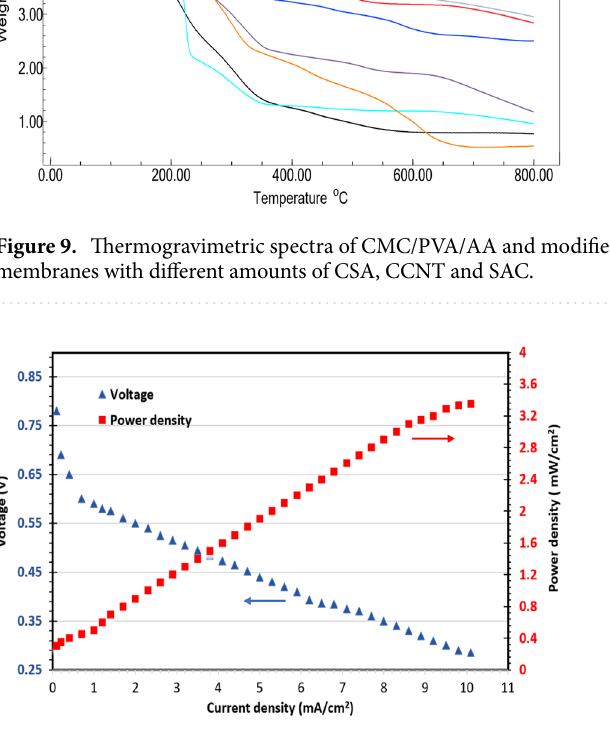
Figure 10. Polarization curves and power density of DMFC with CMC/PVA/AA-4%SAC-2%SAC hybrid polyelectrolytic